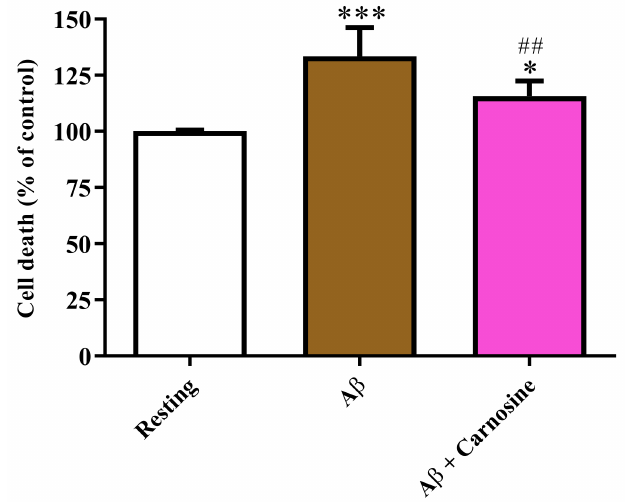
Figure 1. Change in the cell death caused by challenging RAW 264.7 cells with A β 1-42 oligomers and protective effects of carnosine. RAW 264.7 cells were treated for 24 h with A β 1-42 oligomers (2 µ M) in the absence or presence of carnosine (20 mM; 1 h pre-treatment). Data are the mean of 6 independent experiments and are expressed as the percent variation with respect to the cell death recorded in resting (control) cells. Standard deviations are represented by vertical bars. * significantly different from resting cells, p < 0.05; *** significantly different from resting cells, p < 0.001; ## significantly different from A β 1-42 oligomer-treated cells, p <